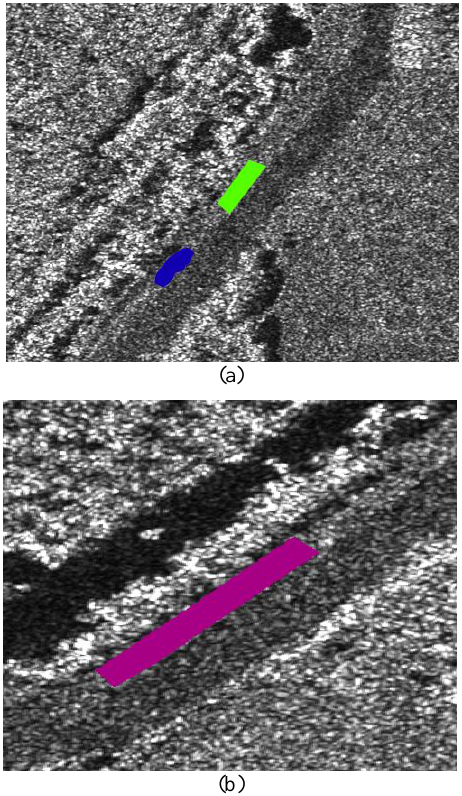
Figure 3. Block diagram of the slide detection algorithm Throughout the training phase, the errors are propagated from the output layer back to hidden layer using the delta rule such that the total squared error of output is minimized.